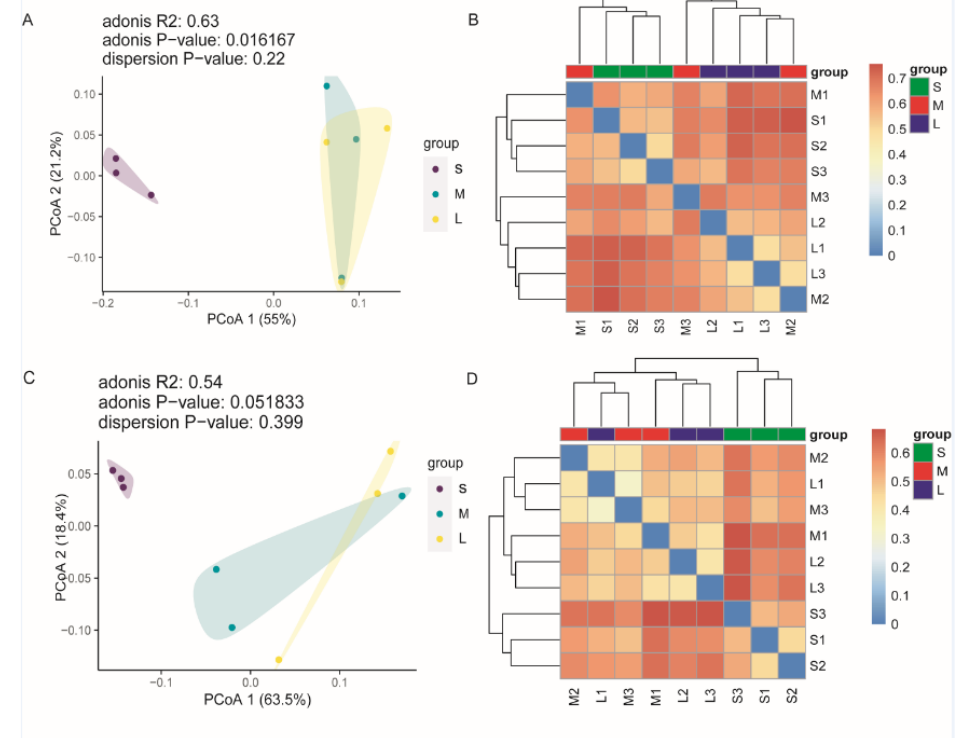
Figure 4. Principal coordinate analysis (PCoA) of microbial community structures based on the Bray – Curtis distance matrix and a heatmap based on unweighted UniFrac distances. ( A , B ) PCoA analysis and unweighted UniFrac (UUF) heatmap analysis of the bacterial community, respectively; ( C , D ) PCoA analysis and UUF heatmap analysis of the fungal community, respectively.